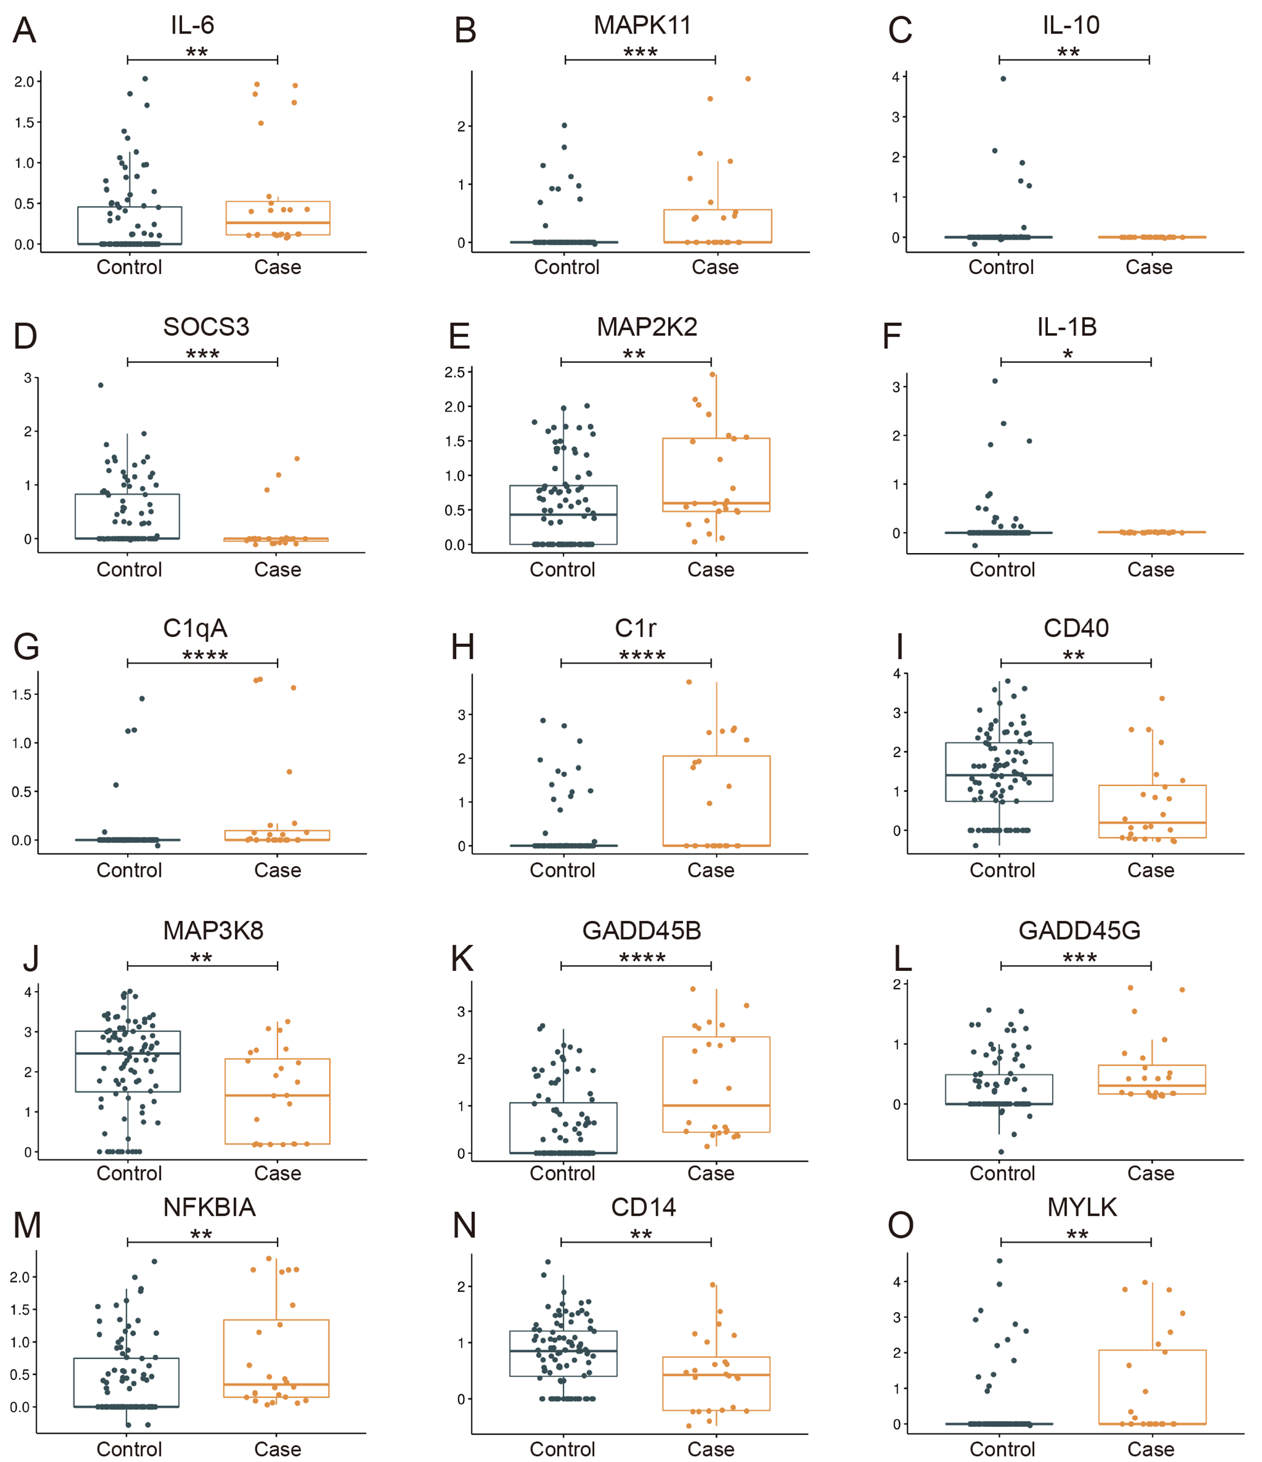
Figure 7. The relative expression level of cytokines of monocyte-derived macrophages in case and control groups. * p <0.05, ** p <0.01, *** p <0.001, **** p <0.0001.